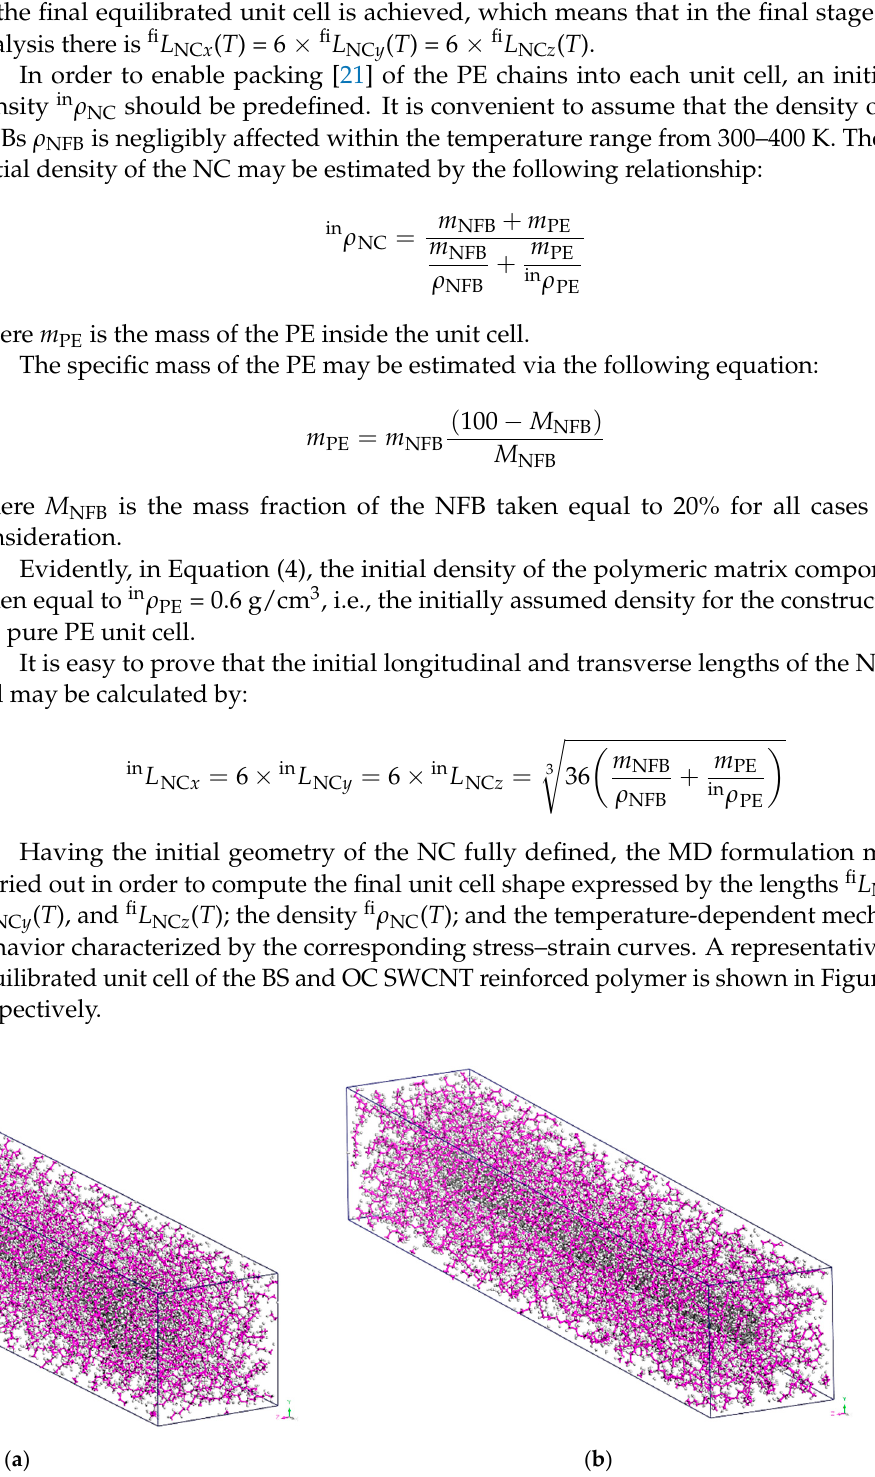
Figure 3. The equilibrated unit cell of the ( a ) BS SWCNT and ( b ) OC SWCNT reinforced PE at a mass fraction of 20% and temperature T = 300 K.